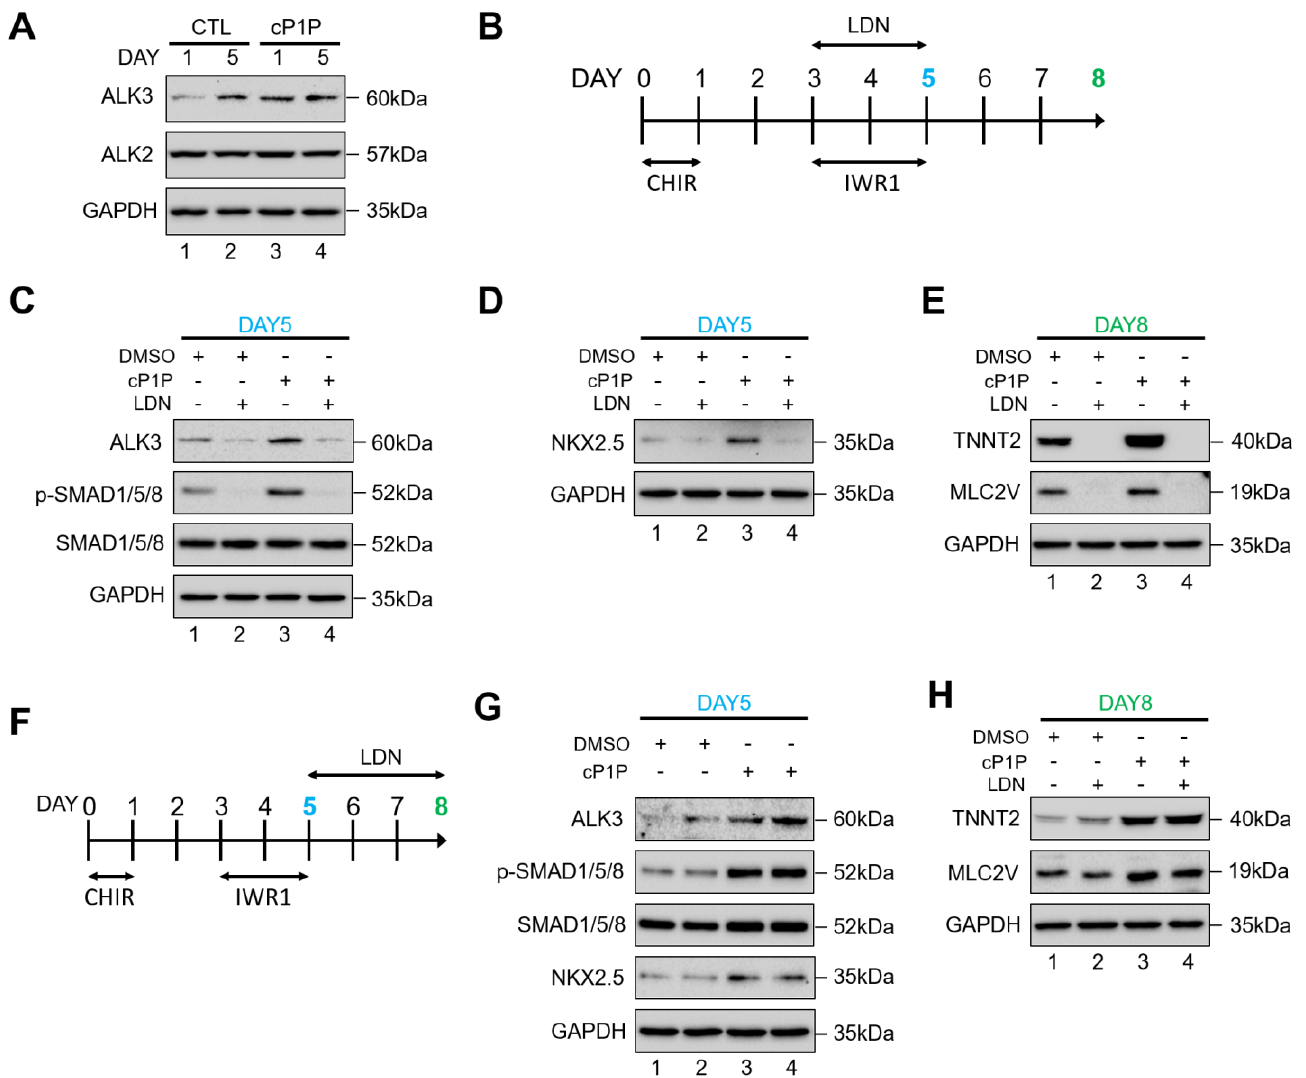
Figure 4. cP1P-augmented cardiac differentiation in hESCs is dependent on BMP receptor-mediated SMAD1/5/8 signaling. ( A ) The activity of BMPR/SMAD signaling with or without cP1P treatment was evaluated by the expression levels of ALK2 and ALK3 by Western blot at the indicated time points along with GAPDH expression as the loading control. ( B ) Schematic representation of the treatment with BMPR inhibitor LDN during days 3 to 5 of CM differentiation coinciding with IWR1 inhibitor treatment. ( C ) The activity of BMPR/SMAD signaling was inhibited by the administration of LDN, as shown by the downregulation of ALK3 and p-SMAD 1/5/8, while cP1P treatment could not reverse the inhibitory effect of LDN. The effects of BMPR inhibition by LDN on cardiomyocyte differentiation, shown by ( D ) the downregulation of NKX2.5 at day 5. ( E ) Treatment of LDN between day 3 to 5 also downregulated the expression of TNNT2 and MLC2V at day 8 of CM differentiation even upon cP1P treatment, as demonstrated by Western blot. ( F ) Schematic representation of the treatment with LDN during days 5 to 8 of CM differentiation. ( G ) Immunoblots of ALK3, p-SMAD1/5/8, SMAD1/5/8, and NKX2.5 at day 5 of LDN treatment in DMSO-treated controls and cP1P-treated CMs. ( H ) Immunoblots of TNNT2 and MLC2V at day 8 of LDN treatment in DMSO-treated controls and cP1P-treated CMs.